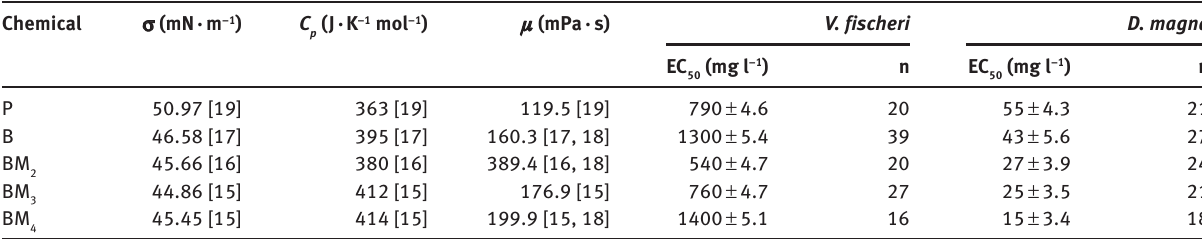
Table 1: Physicochemical data for ILs and their corresponding EC of Daphnia magna